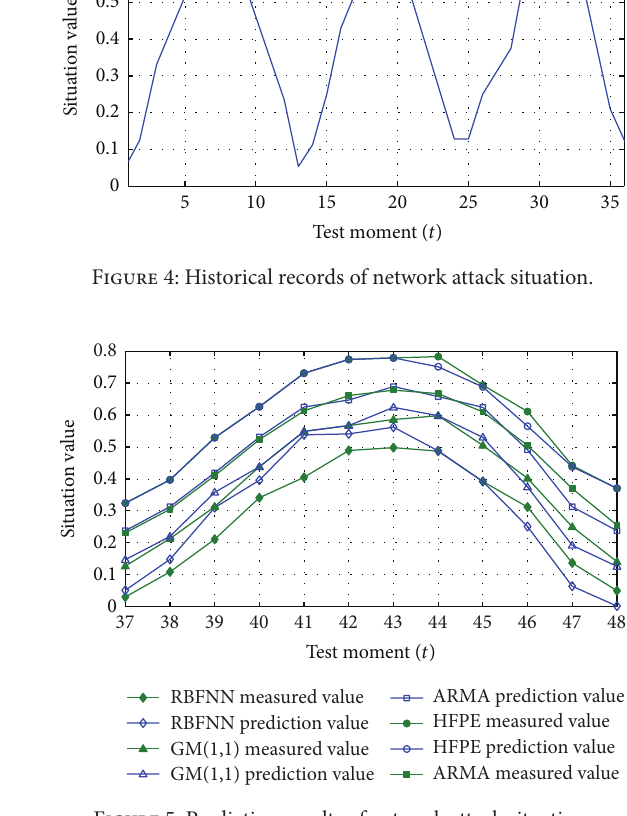
relative errors of HFPE, ARMA, GM(1,1), and RBFNN are 3.28%, 5.89%, 7.18%, and 16.11%, respectively. As shown